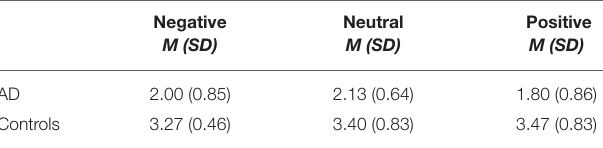
TABLE 3 | Means and SDs of recognition scores per stimulus category and